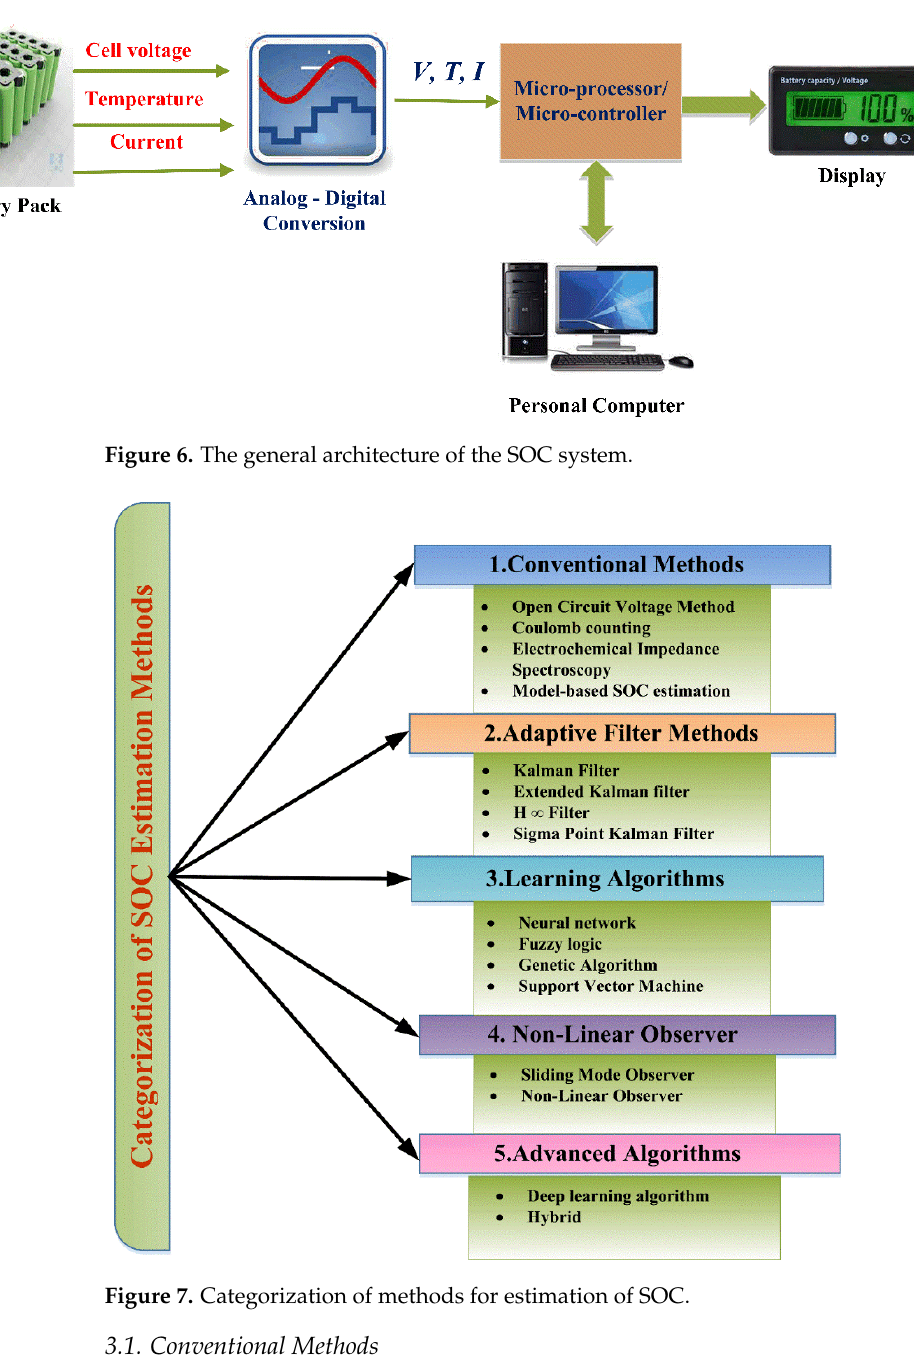
Figure 6. The general architecture of the SOC system.